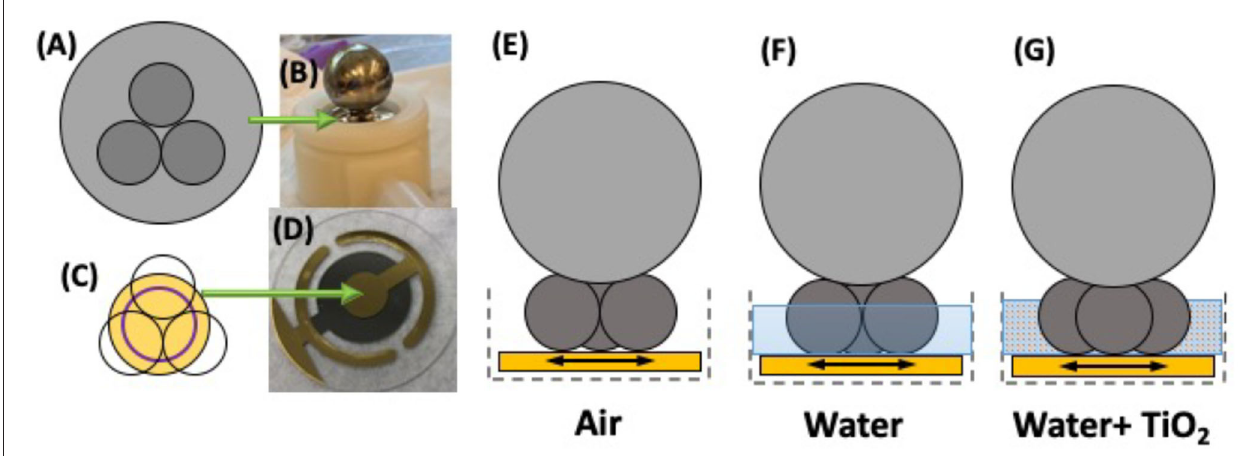
FIGURE 2 | Images and schematics of the experimental apparatus employed here to compare friction coefficients inferred from continuum models to data recorded on QCM 304SS electrodes in contact with 304SS spheres in air, DI water, and DI water + 0.67wt% TiO 2 suspensions. Three close-packed 304SS spheres are rigidly attached to a load (A) and then placed atop an oscillating QCM electrode (B) . The lower side electrode (C,D) , which is smaller than the liquid-facing electrode where contacts are established (E–G) , defines the active area of oscillation.